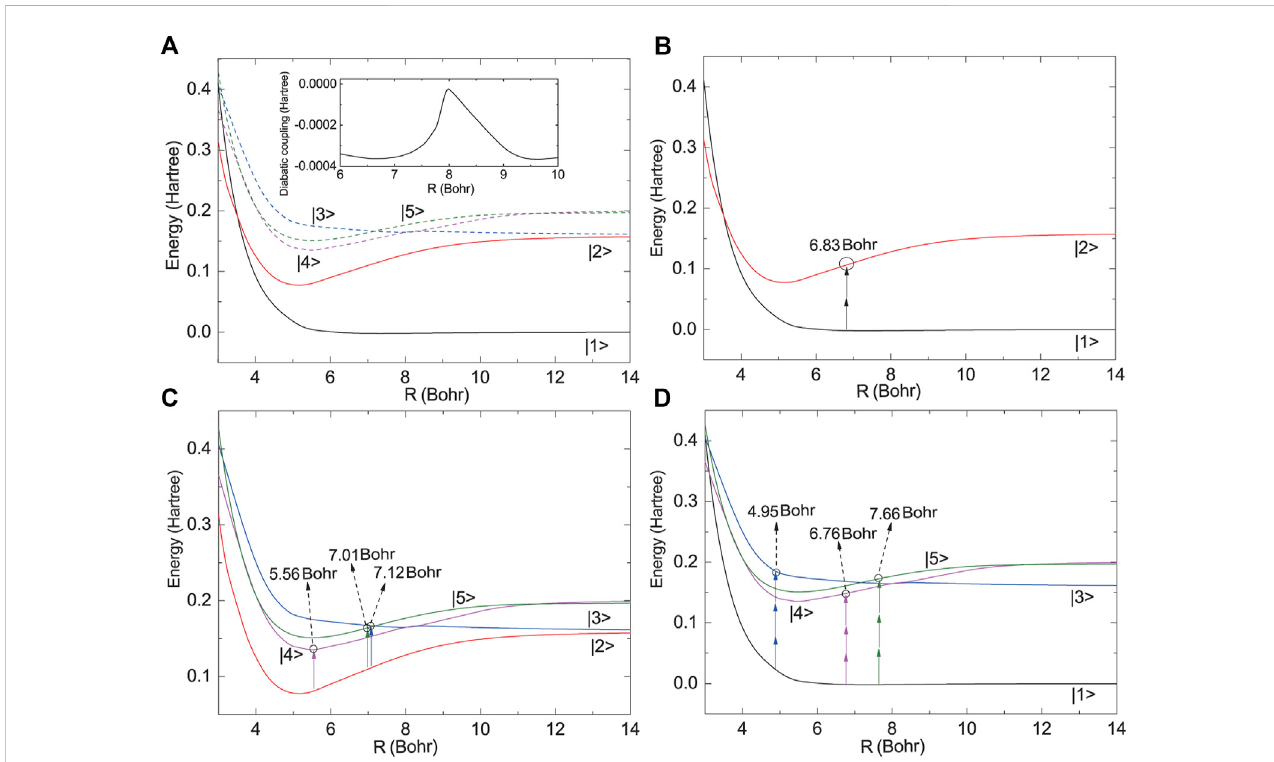
FIGURE 2 (A) The potential energy curves of the fi ve-state-model ofthe Mg 2 system.The diabatic coupling betweenthe|3 〉 and |4 〉 states isshown in theinset. (B) The two-photon coupling between the states |1 〉 and |2 〉 . (C) The one-photon couplings between the states |2 〉 and | u 〉 . (D) The three-photon couplings between the states |1 〉 and | u 〉 . Here, u = 3, 4,